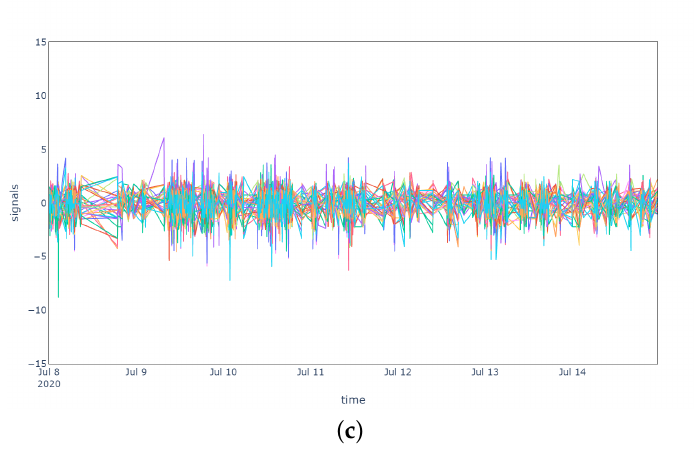
Figure 3. ( a ) shows the sensor signals without the removal of outliers, while ( b , c ) represent the signals over time after the IQR and MC methods were applied respectively for the outlier removal phase.